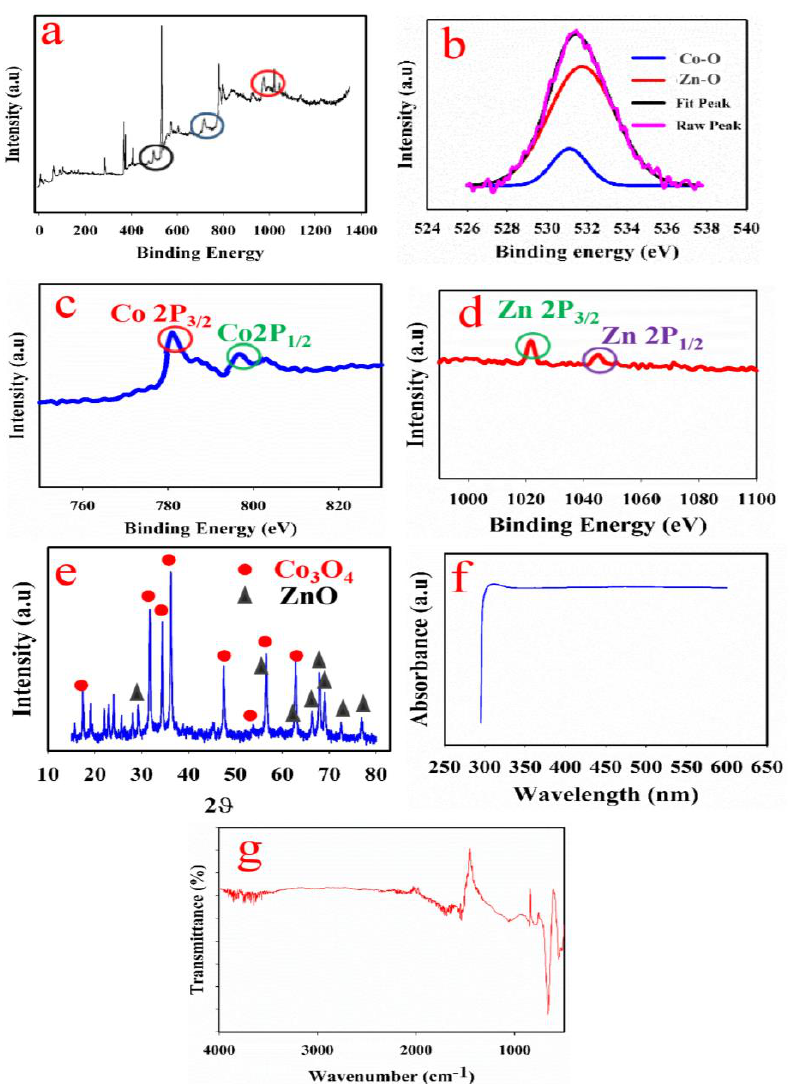
Figure 2. Optical, functional and structural analyses. ( a ) Full XPS spectrum of Co 3 O 4 -ZnO nanorod. ( b ) Deconvoluted peak of oxygen. ( c ) Deconvoluted peak of cobalt. ( d ) Deconvoluted peak of zinc. ( e ) XRD spectrum of Co 3 O 4 -ZnO nanorod. ( f ) Obtained UV-Vis spectrum for Co 3 O 4 -ZnO nanorod. ( g ) FTIR spectrum of Co 3 O 4 -ZnO nanorod.